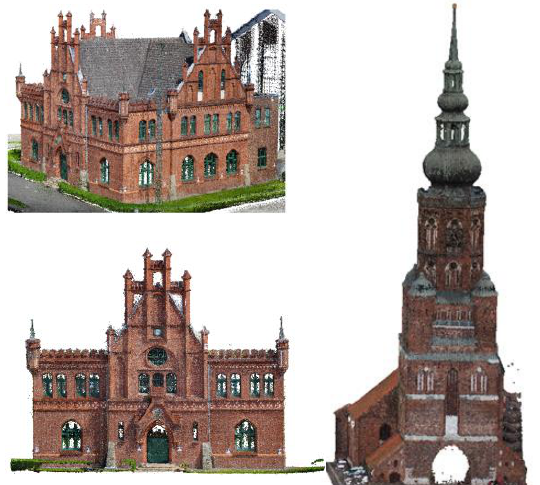
Figure 4. The generated point cloud of first dataset, whole of building (left and up) and the selected side for modelling (left and down), The generated point cloud of second dataset (right) For mesh generation, the size of the holes in point cloud and the average distance between points are set to 0.05m and 0.1m, respectively for first dataset, and 0.1m and 0.3m for second dataset. The optimum values of these parameters are defined experimentally. Therefore, a Delaunay 2.5D triangulation is applied on point cloud and accordingly a mesh model with about 1 million triangles is generated as shown in Figure 5. In Figure 3. A historical building in Dortmund (left), Greifswald this step, some holes should be filled because of windows or Cathedral, St. Nikolai (right) occlusion (for example the holes at top of the door in Figure 4, Left) using curvature continuity constraint.